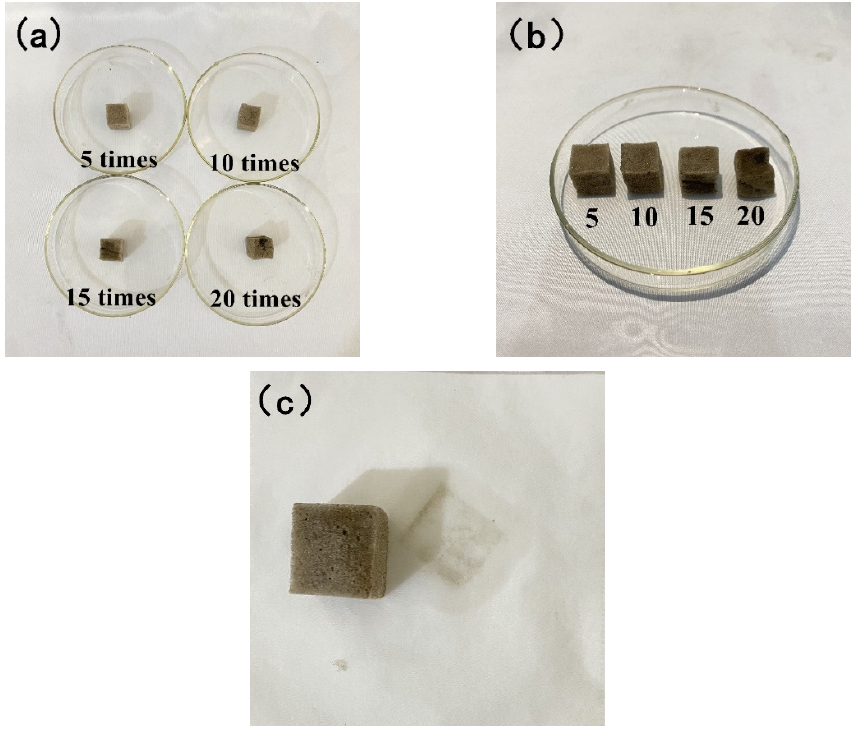
Figure 11. ( a , b ) the appearance of PDMS@Fe 3 O 4 /MS after deoiling 5 times, 10 times, 15 times, and 20 times and ( c ) The paper towel absorbs the residual oil in the sponge.